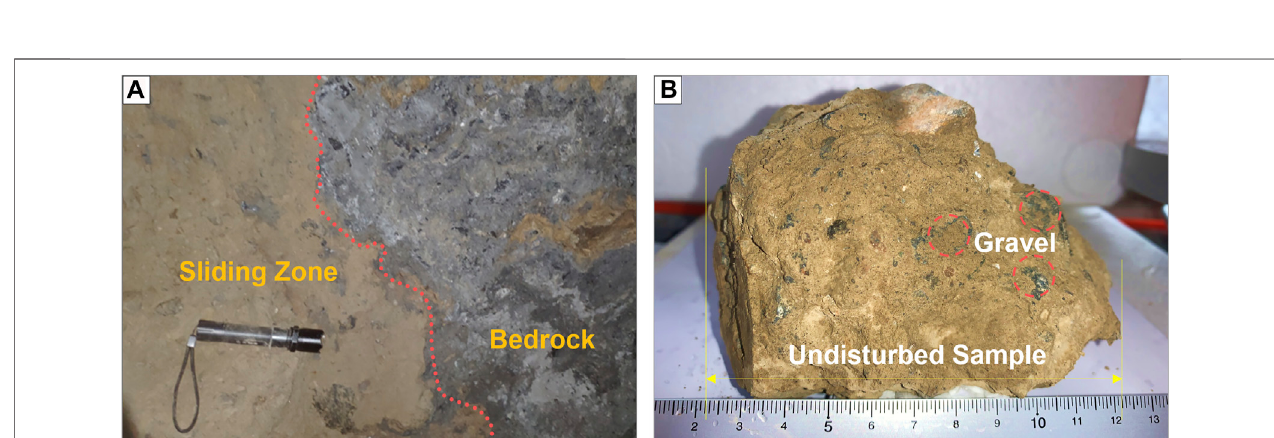
FIGURE 3 | Sliding zone and rock sample (A) Exposed sliding zone, (B) An undisturbed sample.